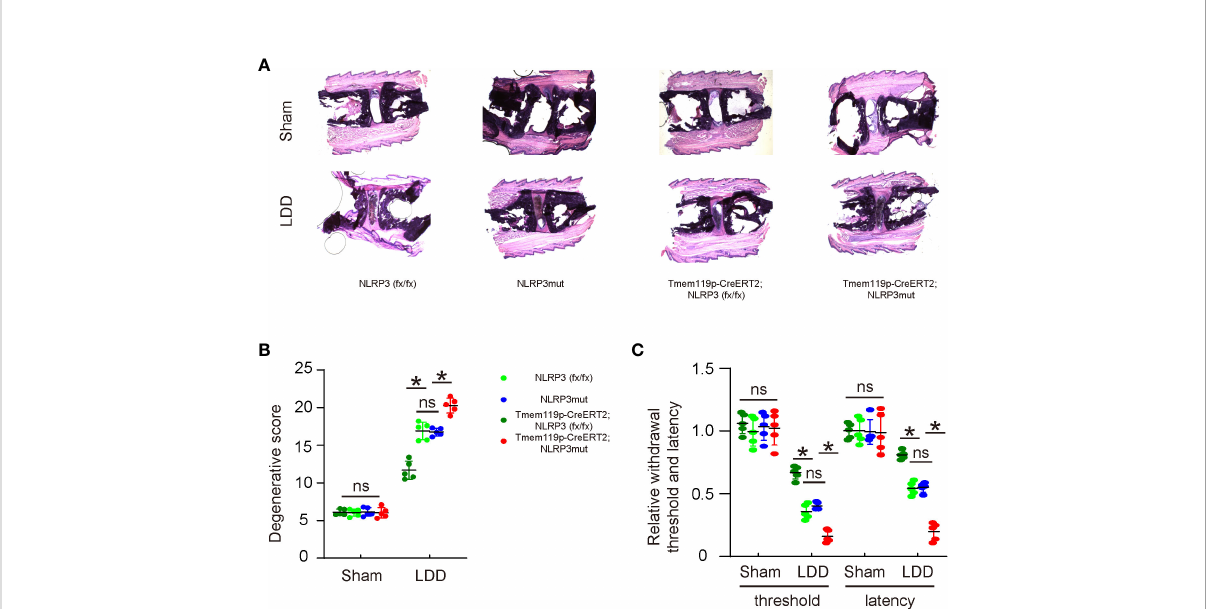
FIGURE 5 NLRP3 depletion in microglia reduces disc degeneration and associated pain. The effects of altering NLRP3 levels in microglia on disc degeneration and associated pain were examined in a mouse model for LDD. A total of 8 groups of mice were included in this experiment. Group 1, NLRP3 (fx/fx) mice received sham operation (Sham); Group 2: NLRP3 (fx/fx) mice received LDD induction (LDD); Group 3: NLRP3mut mice received sham operation; Group 4: NLRP3mut mice received LDD induction; Group 5, Tmem119p-CreERT2; NLRP3 (fx/fx) mice received sham operation; Group 6: Tmem119p-CreERT2; NLRP3 (fx/fx) mice received LDD induction; Group 7: Tmem119p-CreERT2; NLRP3mut mice received sham operation; Group 8: Tmem119p-CreERT2; NLRP3mut mice received LDD induction. Mice were analyzed 8 weeks after LDD or at age of 23-week-old. (A, B) Surgical induction of LDD and the quanti fi cation of disc degeneration were performed, shown by representative images (A) and by quanti fi cation for degenerative scores (B) . (C) A Von Frey fi lament test for pain evaluation, shown by the relative mechanically induced withdrawal threshold and by thermally induced withdrawal latency of the paw (normalized to those from NLRP3mut (=1)). *p<0.05. ns: no signi fi